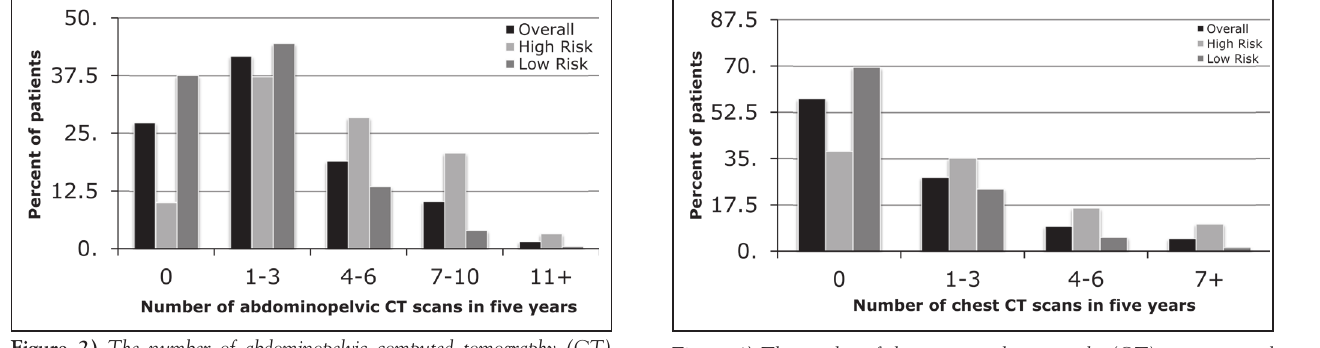
Figure 4) The number of chest computed tomography (CT) scans received in the five-year follow-up period, stratified according to high and low risk for recurrence